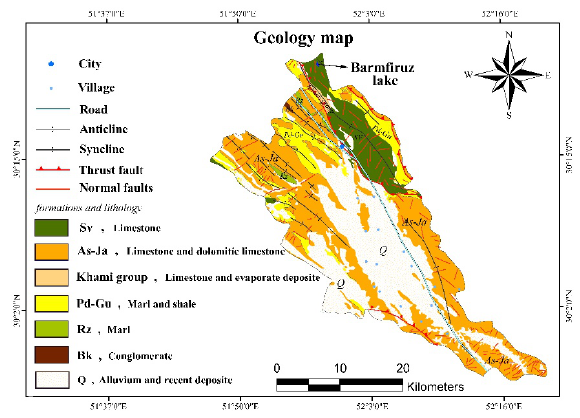
Fig. 2 Geology map of the study area (extracted from 1:100000 Ardakan, Kelestan and Dorudzan geological maps of Geological Survey of